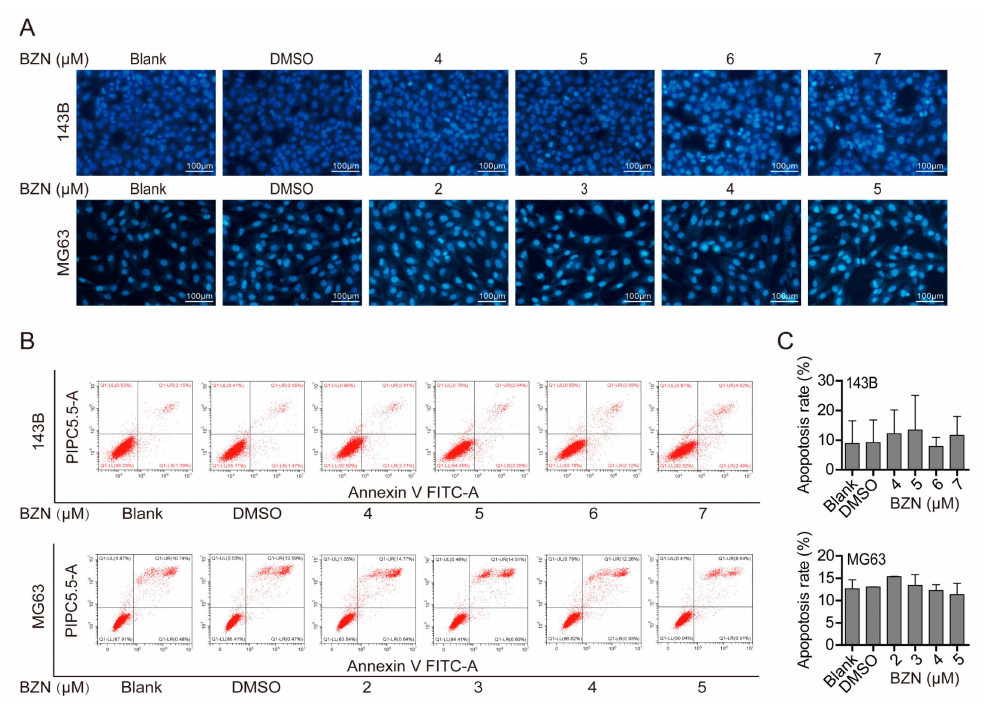
Figure 3. BZN-induced suppression of OS cell growth may not be related to apoptosis. ( A ) The effect of BZN on apoptosis of OS cells (Hoechst 33258 staining, scale bars: 100 µ m). ( B ) The effect of BZN on apoptosis of OS cells (flow cytometry). ( C ) Quantitative analysis of apoptosis rates determined by flow cytometry. Data are shown as mean ± SD from three independent